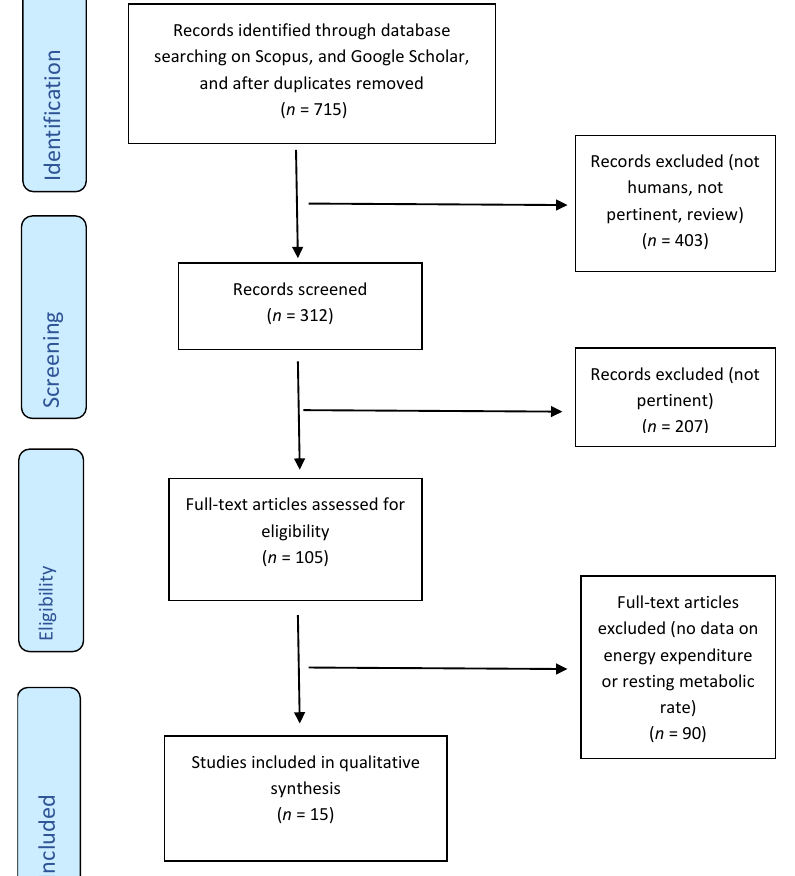
Figure 1. Flow diagram.